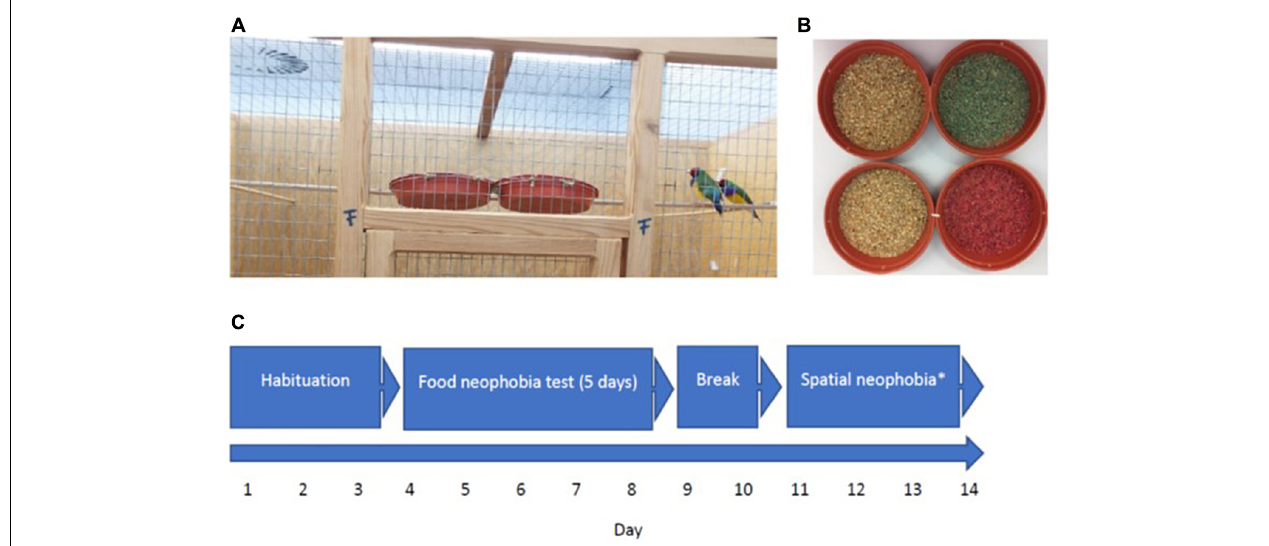
FIGURE 1 | (A) Upper part of experimental cage with the two feeders side-by-side, (B) familiar (left) and novel green (experiment 1) and red (experiment 2) food (right), (C) flow chart demonstrating experimental design (repetition of experiment not shown); *see Mettke-Hofmann et al. (2020).